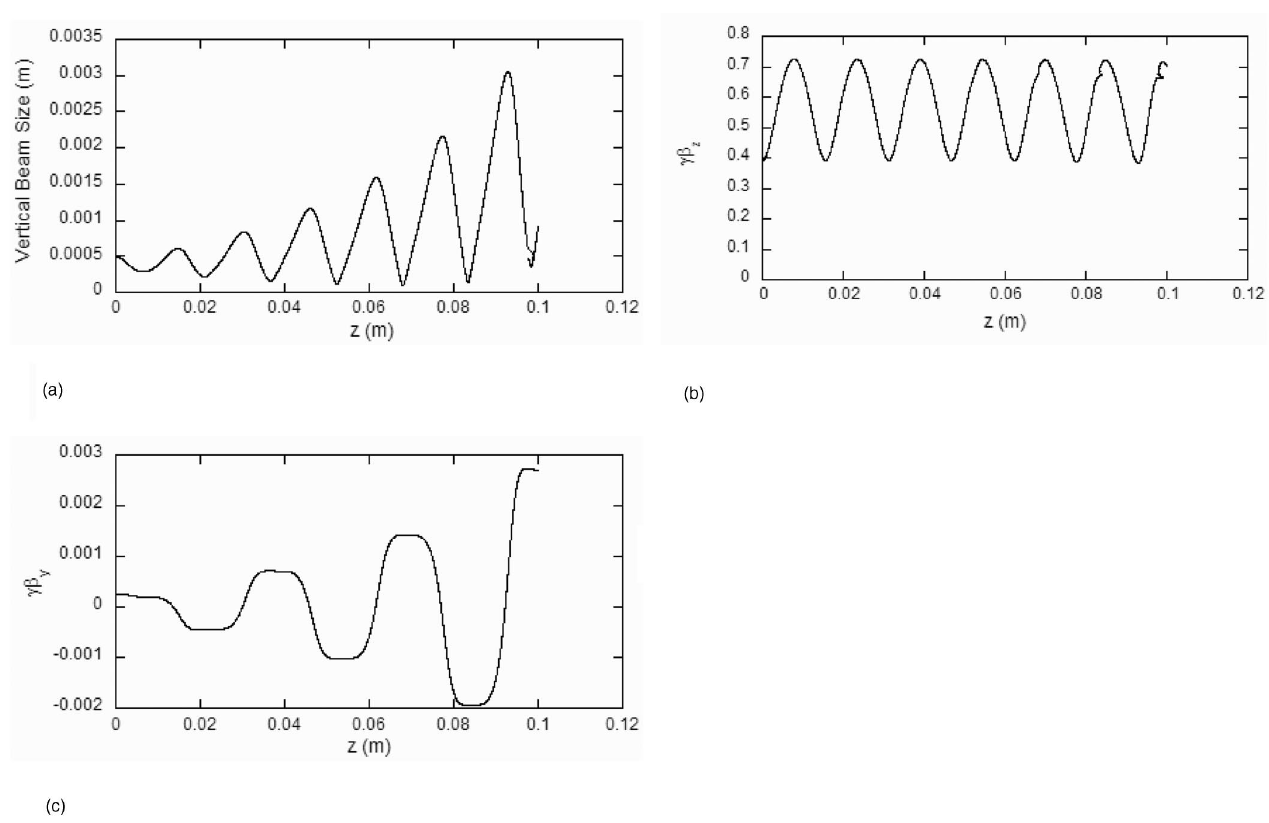
FIG. 12. Instability threshold for wiggler focusing with an emittance-dominated beam, period 3.125 cm. (a) Vertical beam size versus axial position. (b) Longitudinal beam momentum versus axial position. (c) Vertical momentum versus axial